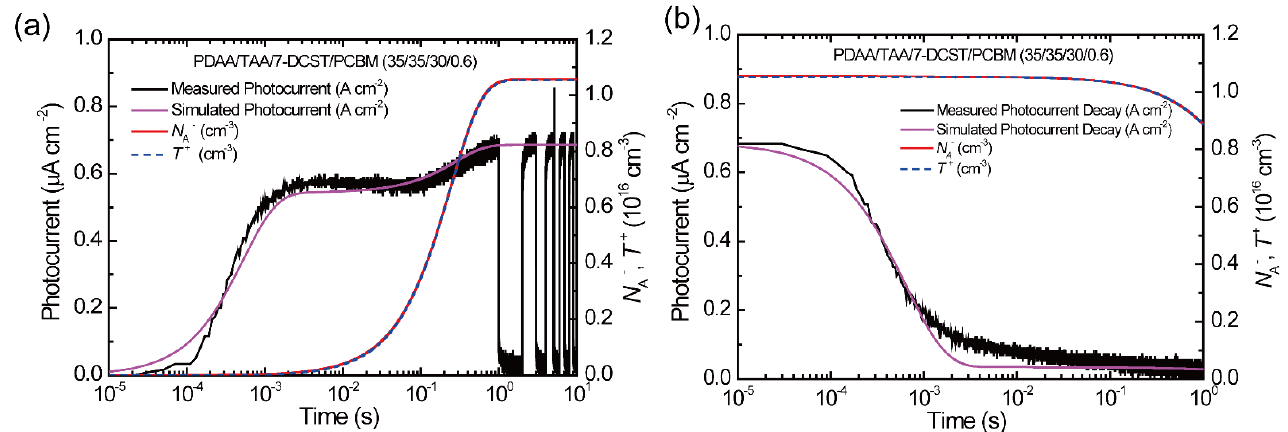
Figure 6. ( a ) Rising transient photocurrent (black plots) and the simulated photocurrent (pale purple curve) for PDAA/TAA/7-DCST/PCBM: red curve, transient density for the sensitizer anion N A − ; blue curve, transient density for filled shallow traps T + ; ( b ) decay